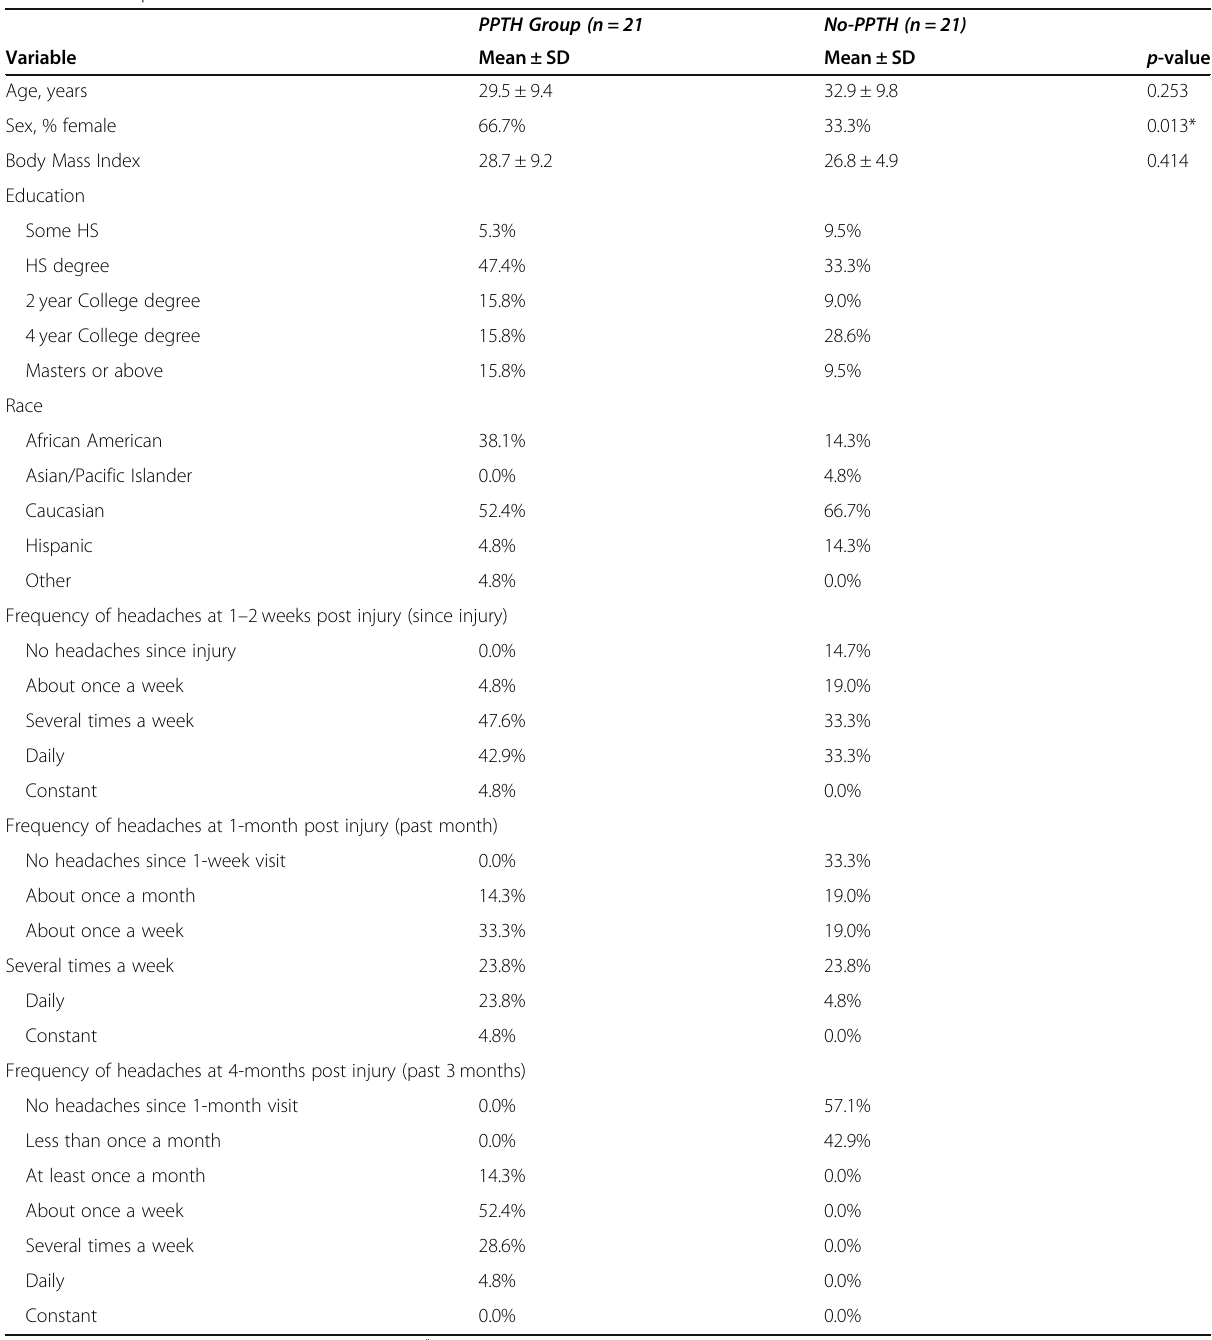
Table 1 Participant